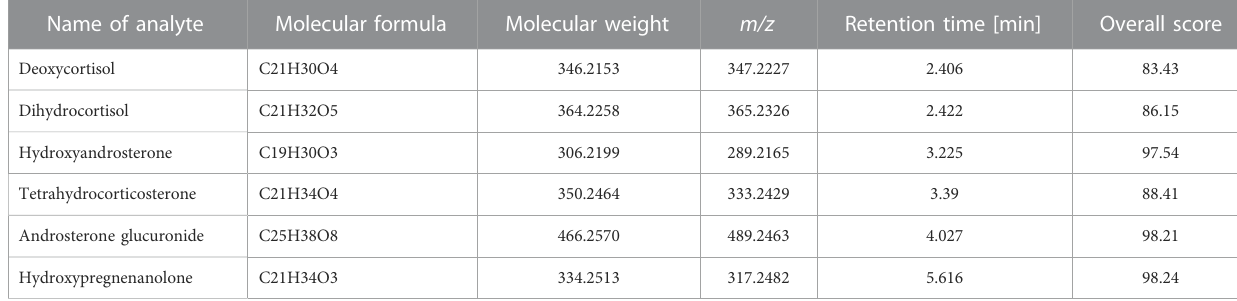
TABLE 5 Additional steroid hormones annotated from urine samples with the use of Find by Formula algorithm. Name of